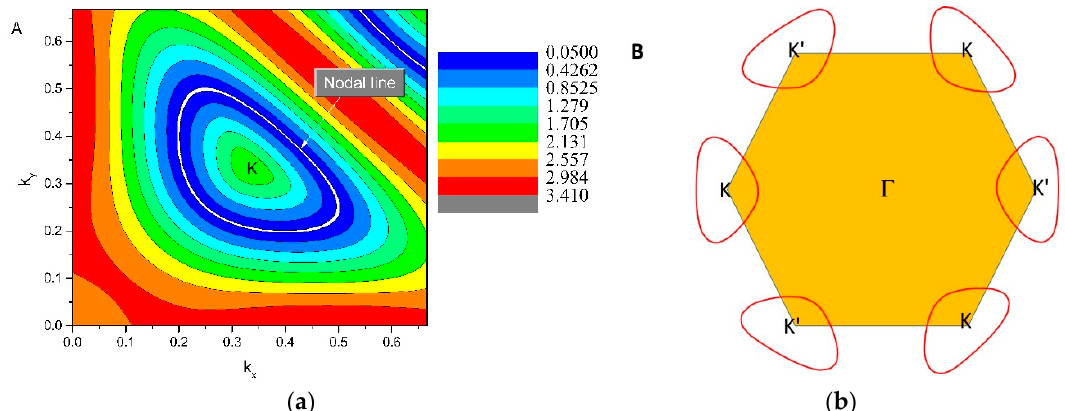
Figure 6. ( a ) 2D shape of the K-centered nodal line in the k z = 0 plane (highlighted by the white line) and ( b ) an illustration of one pair of nodal lines (highlighted by red lines) in the k z = 0 plane.